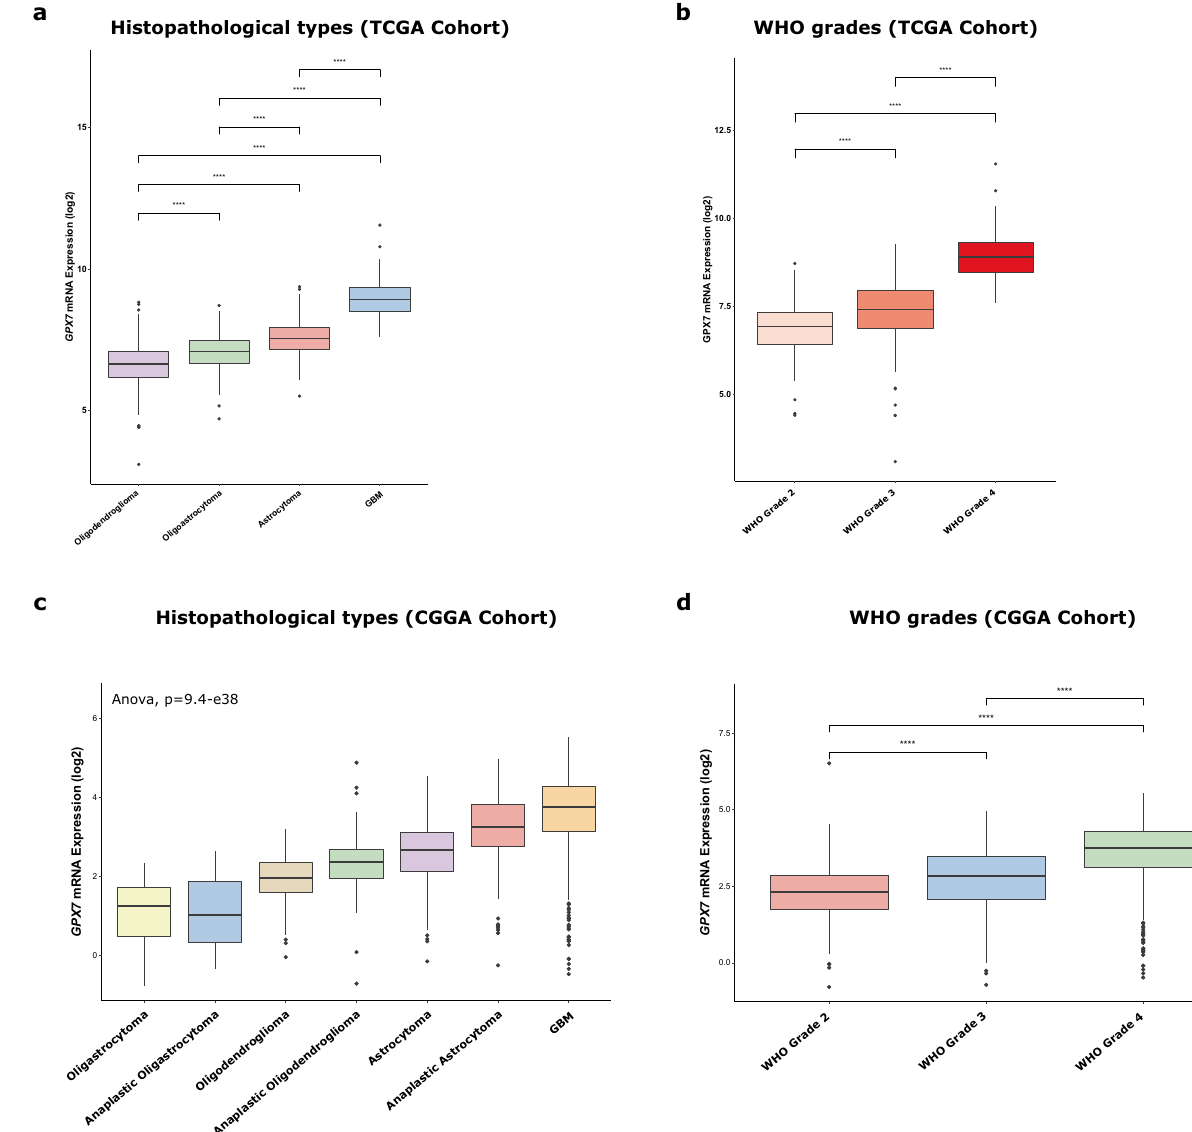
Figure 2. GPX7 is highly expressed in gliomas and is significantly associated with the advanced stage of tumors. ( a ) Relative mRNA expression of GPX7 in histopathological types of gliomas; ( b ) Relative mRNA expression of GPX7 in different gliomas WHO grades (2, 3 and 4) from the TCGA cohort; ( c ) Relative mRNA expression of GPX7 in histopathological types of gliomas from the CGGA cohort; ( d ) Relative mRNA expression of GPX7 in different gliomas WHO grades (2, 3 and 4) from the CGGA cohort. Statistical significance was denoted by asterisks: * p ≤ 0.05; ** p ≤ 0.01; *** p ≤ 0.001; **** p ≤